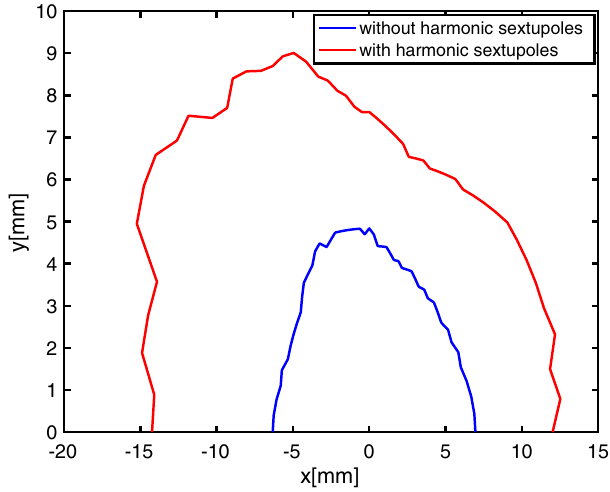
FIG. 11. A comparison of dynamic apertures with and without harmonic